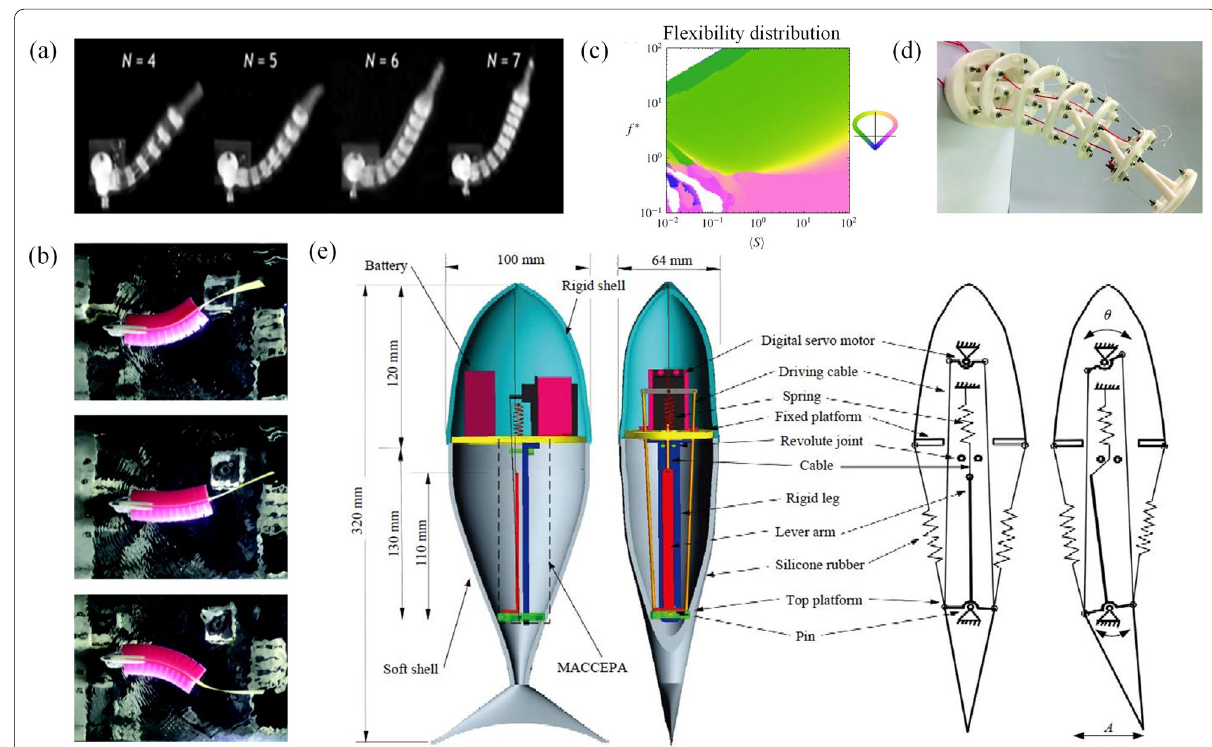
Figure 6 Body stiffness research: ( a ) The biological principle test [182]; ( b ) The whole body stiffness research [184]; ( c ) The optimal distributed stiffness for maximum efficiency [187]; ( d ) The tensegrity robotic fish structure [192]; ( e ) The MACCEPA structure [190]